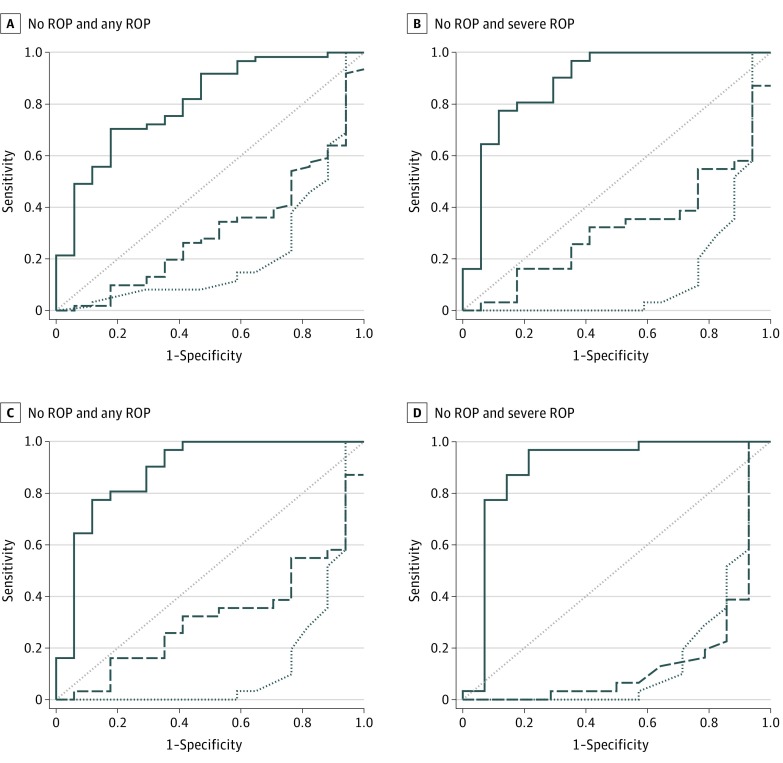
Receiver Operating Characteristic (ROC) Curve AnalysisA and B, During the first month of life. C and D, At 32 weeks’ postmenstrual
age. The solid line indicates the interaction between arachidonic acid and
gestational age, the dashed line indicates gestational age, and the butted and
dotted line indicates arachidonic acid. ROP indicates retinopathy of
prematurity.